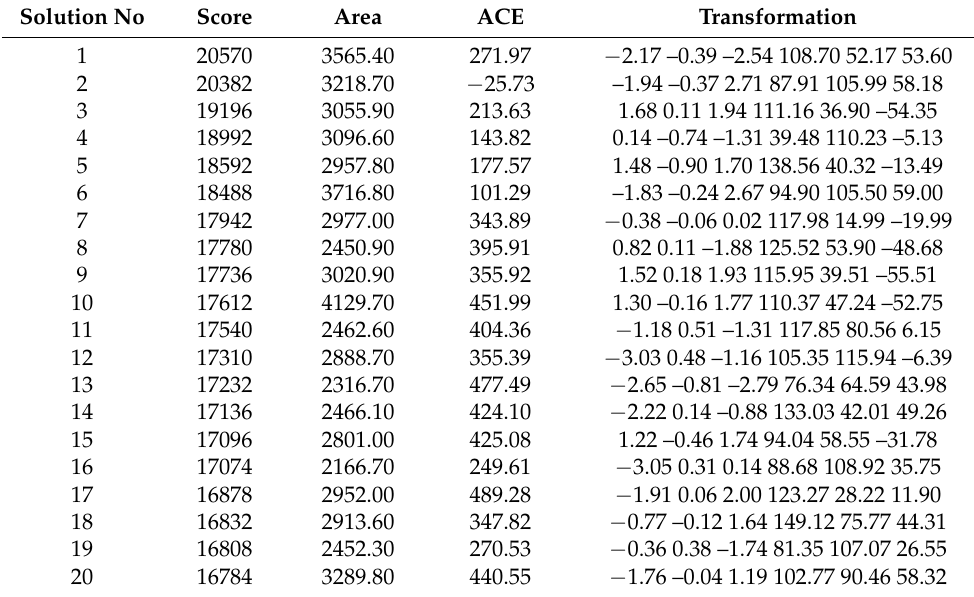
Table 8. Vaccine solutions docked for the top 20 MHC-II vaccines.